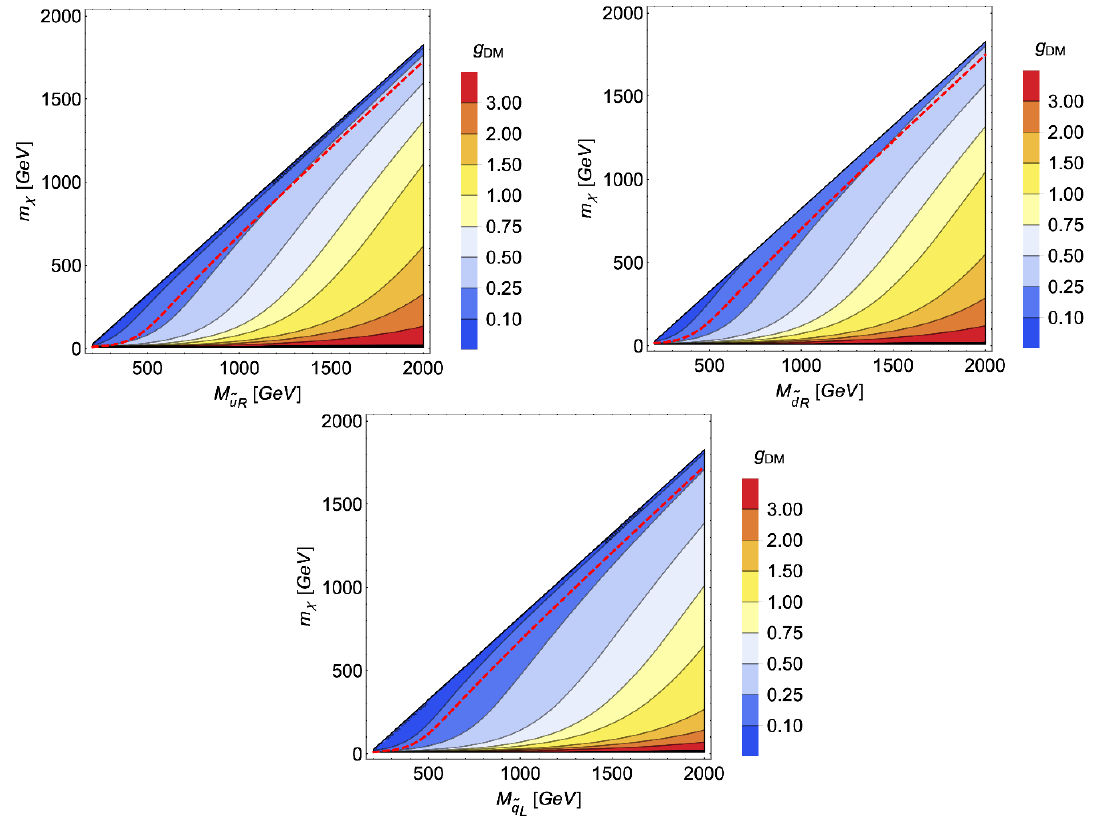
Figure 6 . Limits on g DM in the plane of the dark matter and mediator masses from the SI cross sec- tion for the u R (upper left), d R (upper right) and q L (bottom) models. The red dashed line indicates the region of parameter space above which the partial width for the mediators is less than (cid:3) QCD .